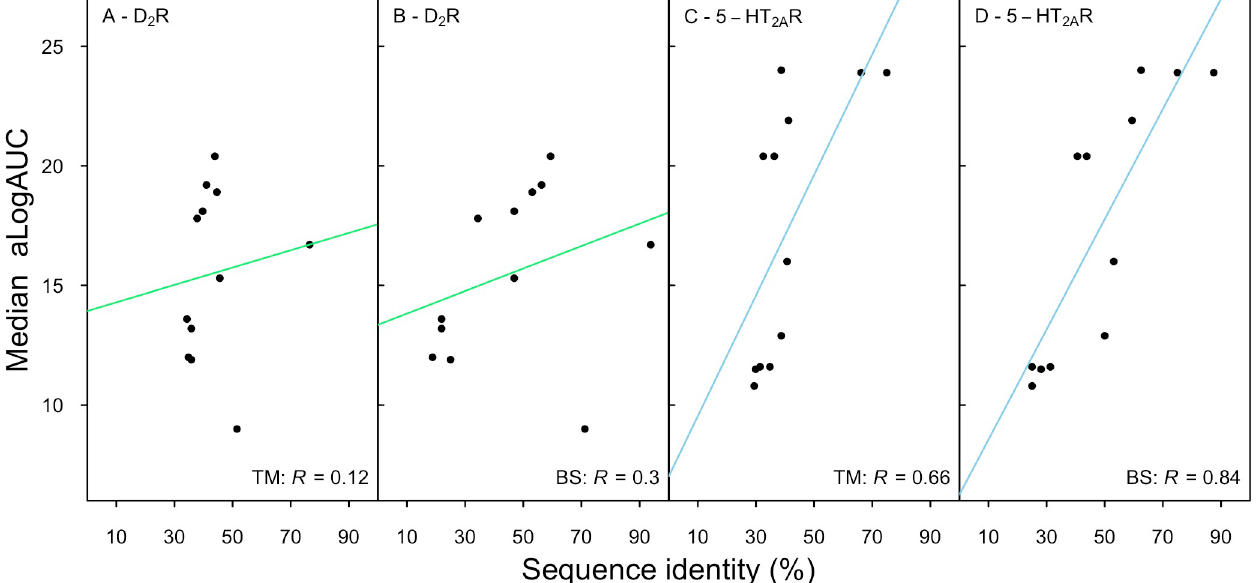
Fig 4. Relation between ligand enrichment and sequence identity. The median aLogAUC values of the D 2 R (A-B) and 5-HT 2A R (C-D) homology models based on aminergic templates with different TM (A and C) or BS (B and D) sequence identities. The solid line represents a linear regression and R is Pearson’s correlation coefficient.